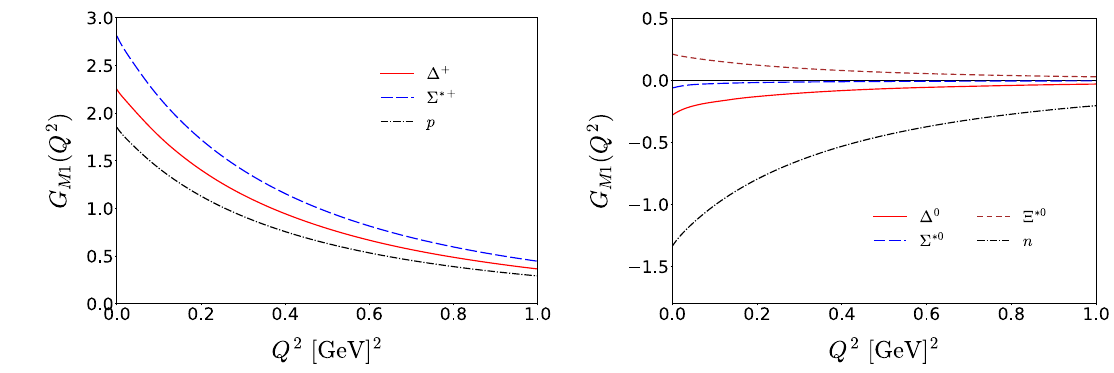
decuplet with those of the neutron electric form factor. The charged baryon form factors behave in a way very similar to the proton one. On the other hand, the neutral E 0 form factors are in general different from that of the neutron. For example, that of (cid:4) ∗ 0 becomes even negative. The left panel of Fig. 15 presents the results of the M 1 form factors of the positively singly charged baryon decuplet in comparison with those of the proton electric form factor, whereas in the right panel of Fig. 15, the right panel shows those of the neutral baryon decuplet being compared with those of the neutron electric form factor. The general ten- dency of the results on the M 1 form factors of the charged baryon decuplet are similar to the proton one. However, those of the neutral baryons are rather different from these of the neutron. The magnitudes of the magnetic dipole moments of the neutral decuplet baryons are very small, compared to that of the